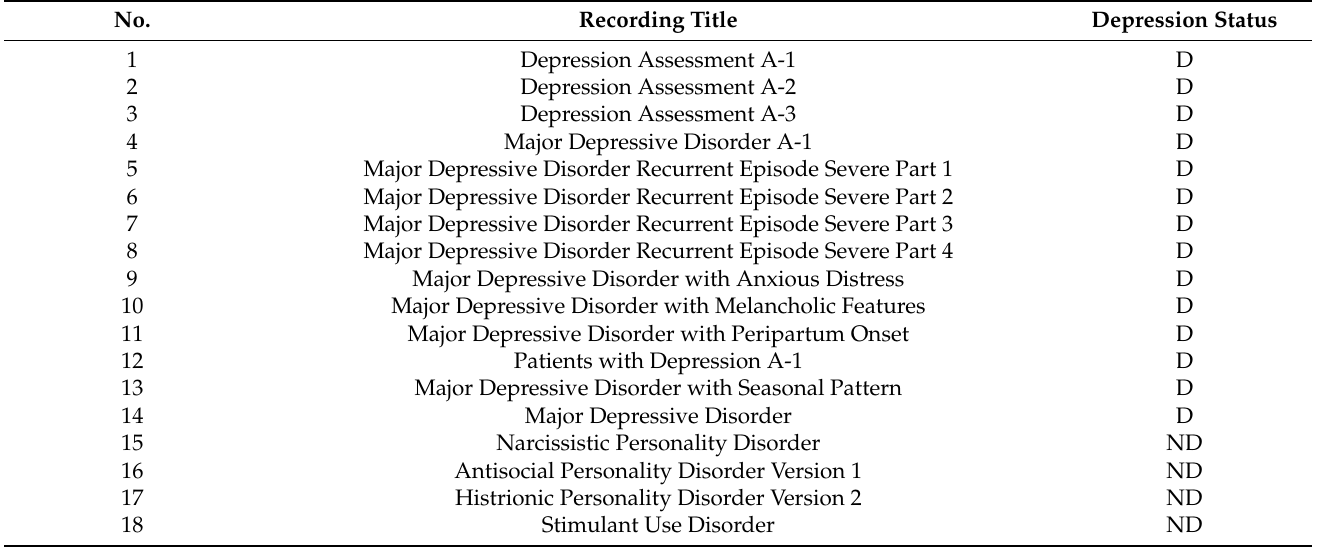
Table 2. The selected SymptomMedia